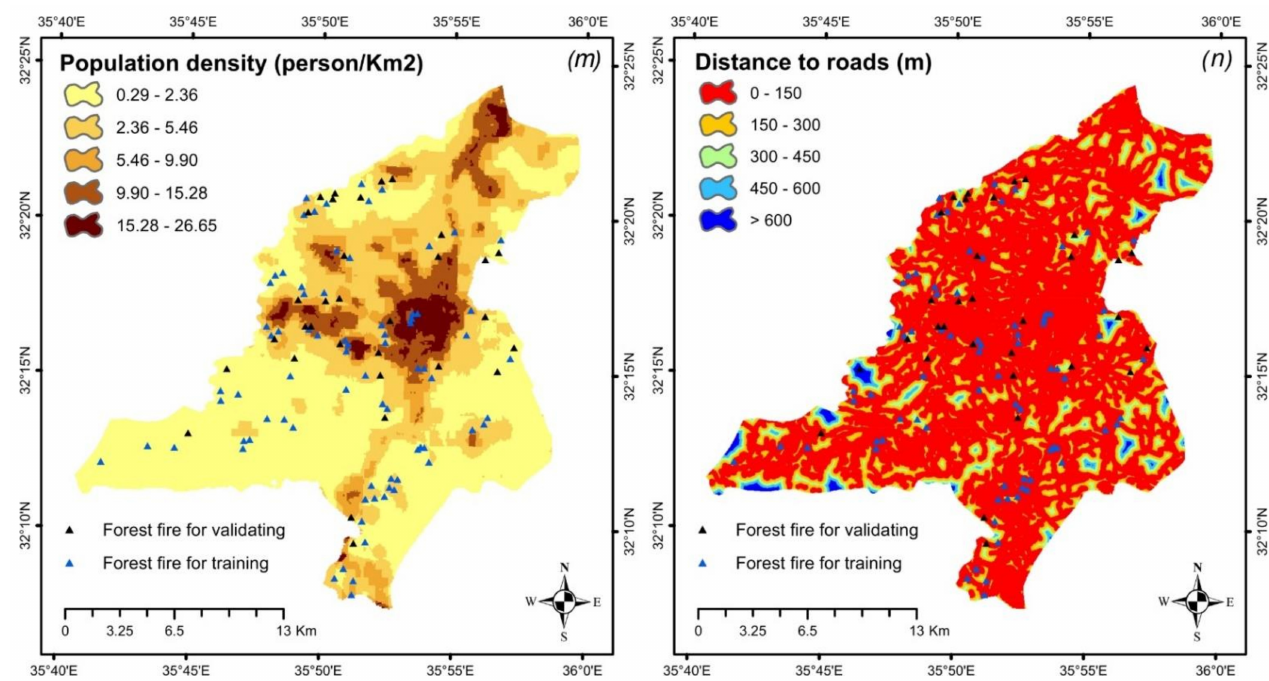
Figure 2. Factors involved in forest fire susceptibility mapping; ( a ) elevation, ( b ) slope, ( c ) aspect, ( d ) land use, ( e ) NDVI, ( f ) rainfall, ( g ) temperature, ( h ) wind speed, ( i ) radiation, ( j ) soil texture, ( k ) TWI, ( l ) distance to drainage, ( m ) population density and ( n ) distance to